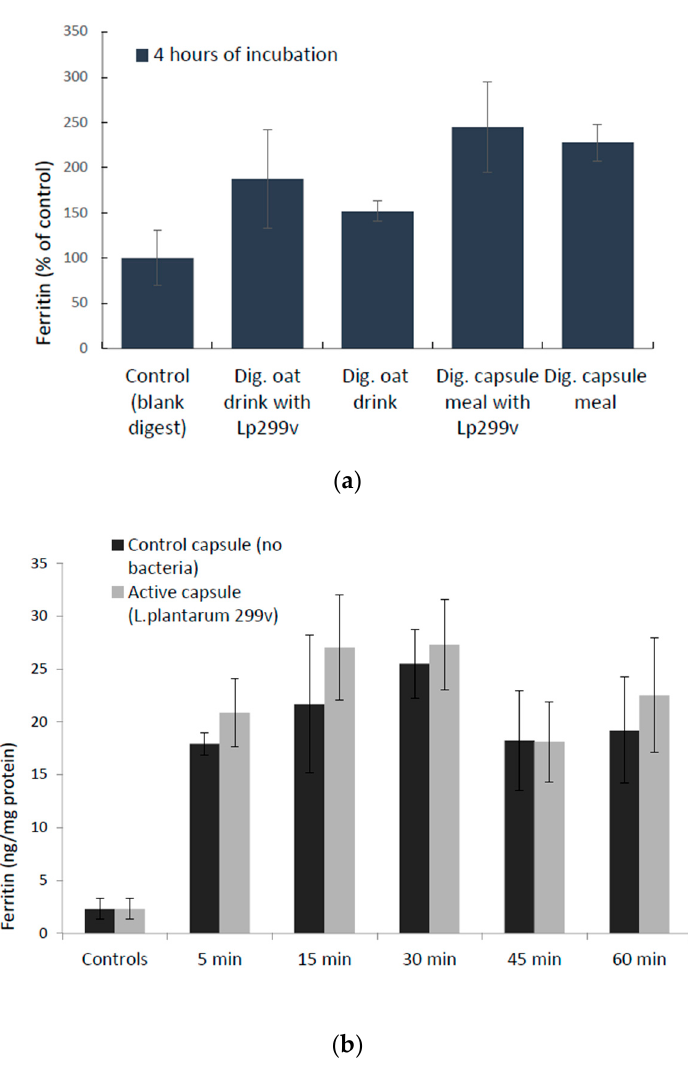
Figure 4. Iron uptake (ferritin expression) in Caco-2/HT29 MTX cells. ( a ) Data are means ± SD, n = 3 for digested (dig.) oat drink trials and n = 2 for capsule meal trials; each trial was done in triplicates. The differences between the study products and their controls (no bacteria) were not significant. ( b ) Cellular ferritin levels in Caco-2/HT29 MTX cells in response to the content of iron capsules, with and without L. plantarum 299v. Data are means ± SD, n = 2, in which each trial was done in triplicates. The differences between active capsules and control capsules (no bacteria) were not significant.